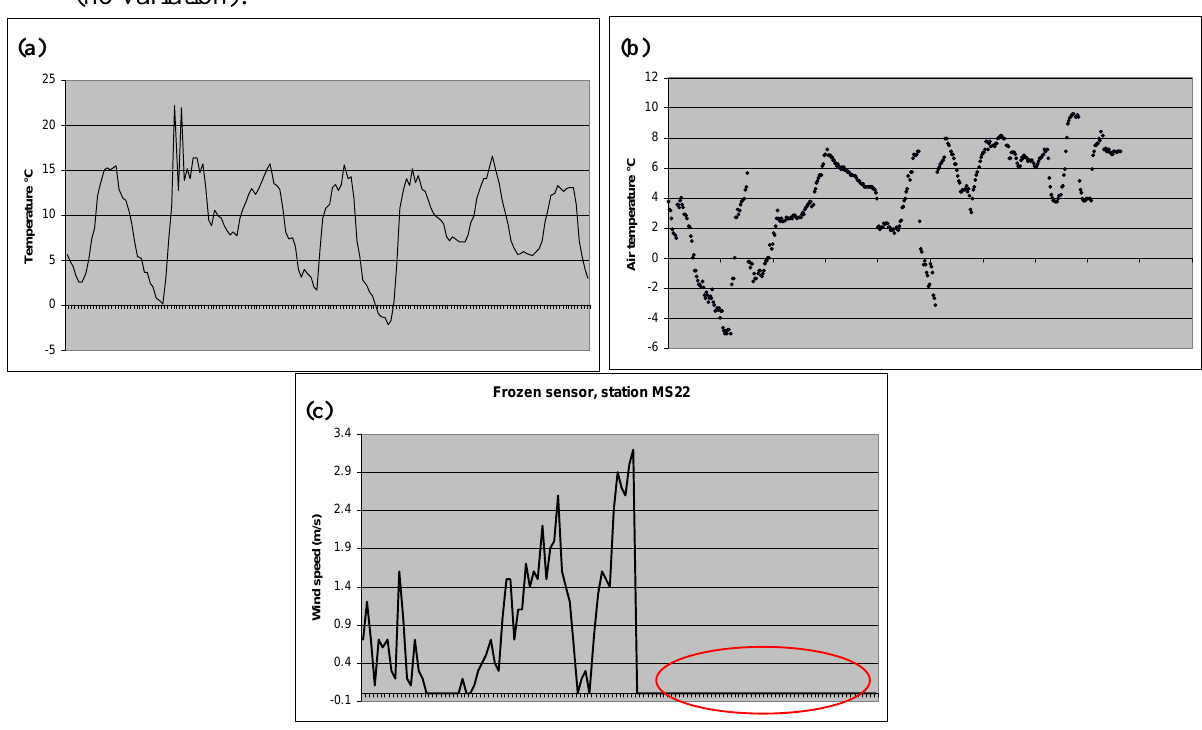
Figure 5. Problems that have occurred in SoilWeather WSN data. Y-axis denotes different parameters and the x-axis denotes time (approx. 1 week). (a) Suspicious spike in air temperature data. (b) Gaps in the air temperature data. (c) Wind speed is constantly 0 m/s (no